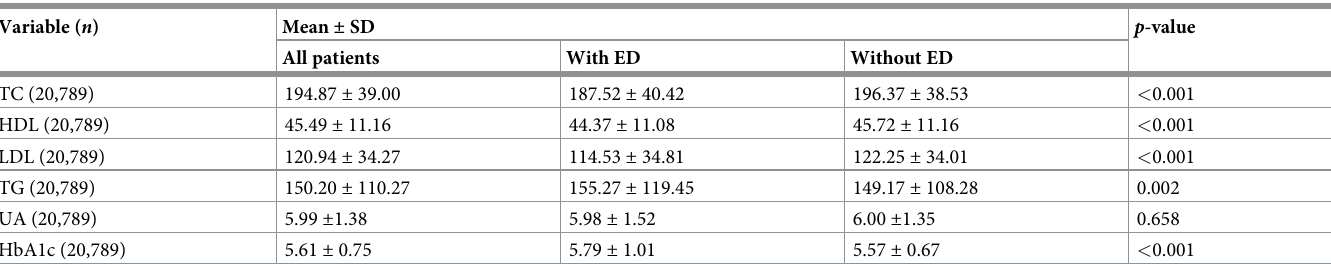
Table 4. Laboratory test results in relation to ED (n = 20,789). Variable ( n